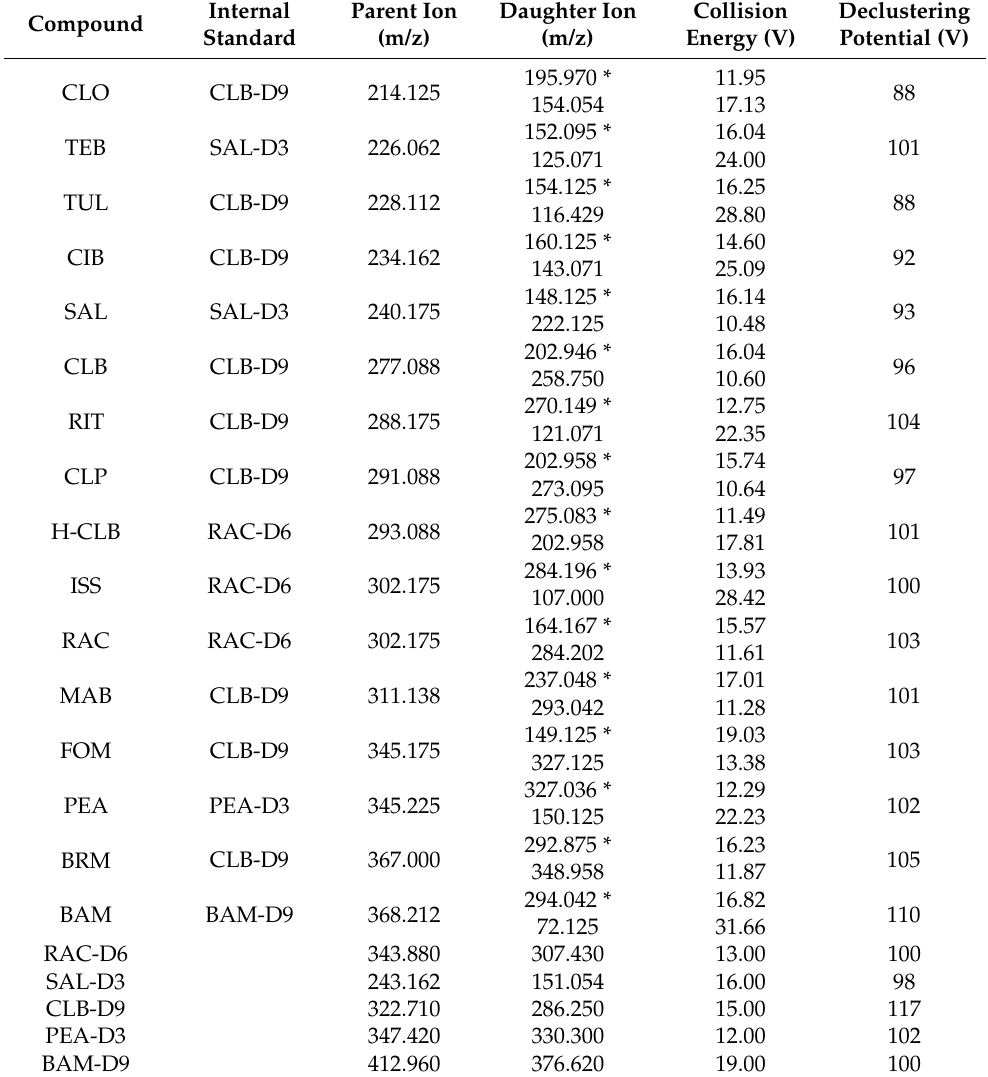
Table 1. Mass spectrometric analysis parameters of sixteen β